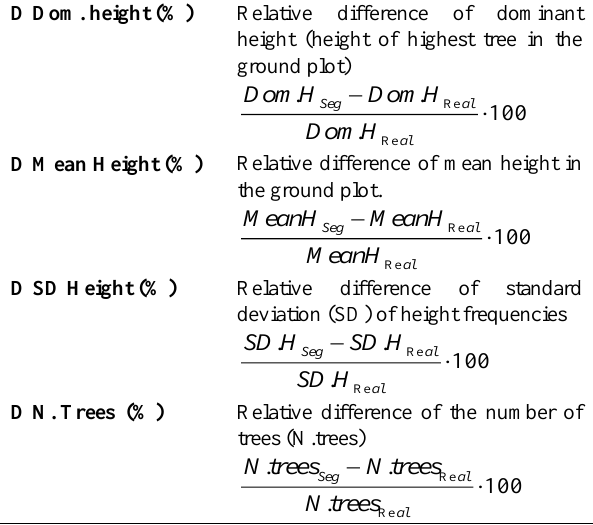
Table 3. Definition of some metrics in plot rows in Figure